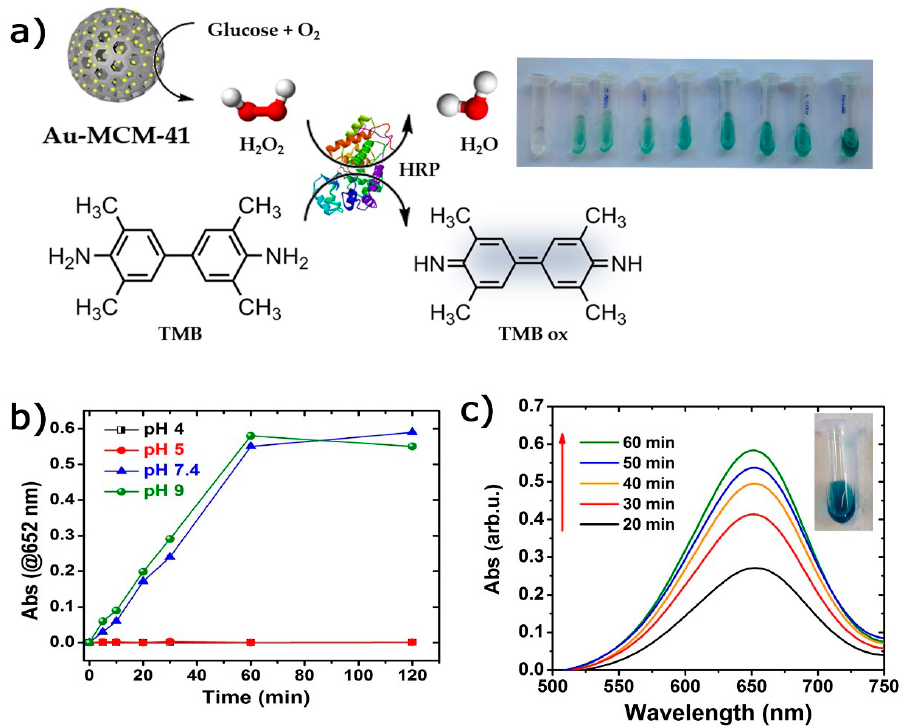
Figure 3. Colorimetric determination of the presence of hydrogen peroxide as reaction product retrieved from the glucose oxidation reaction (TMB assay): ( a ) Schematic display of the formation of hydrogen peroxide and its subsequent redox reaction mediated by a horseradish enzyme that readily reacts with TMB to render the blue colored oxidized derivative with maximum absorption spectrum centered at 652 nm; (inset: digital image showing the evolution of the blue-colored vials upon increasing reaction times related to increasing formation of H 2 O 2 ); ( b ) Time-dependent evolution of the maximum absorption of TMB(ox) at different pH conditions and keeping reaction temperatures of 37 °C; ( c ) Representative UV-Vis spectra of the TMBox dye after increasing reaction times (inset: digital image of the final solution after 60 min reaction); Experimental conditions: [catalyst] = 0.025 mg/mL; [glucose] = 150 mM; reaction media buffered with 0.2 M sodium acetate/acetic acid.